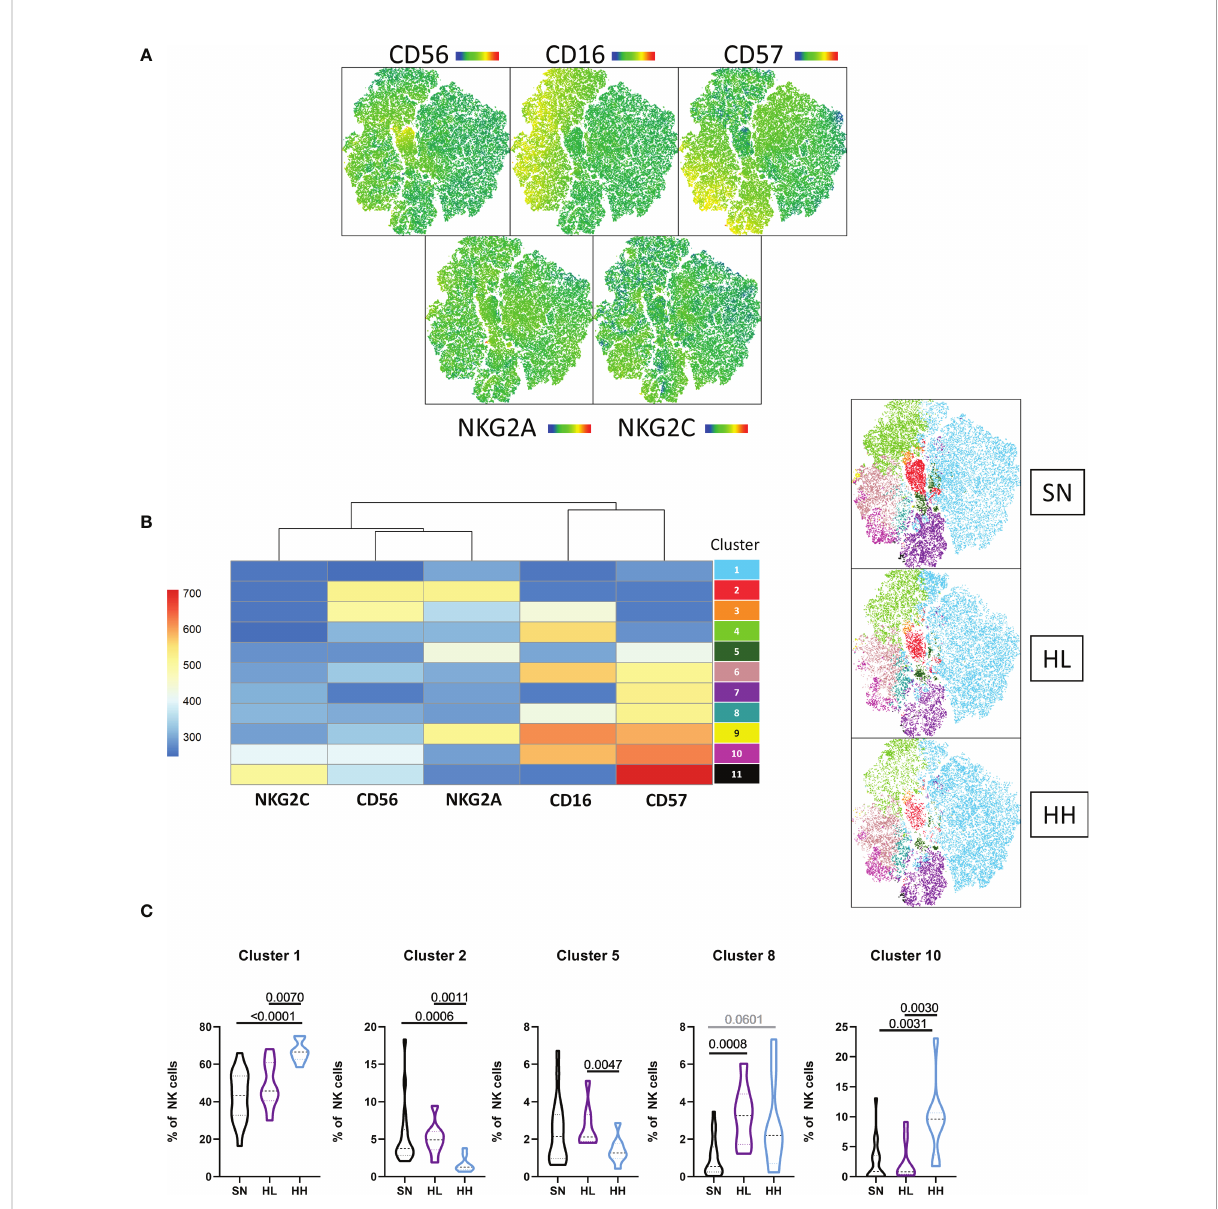
FIGURE 2 Unsupervised analysis of the NK cell repertoire. (A) tSNE dimensional reduction was performed in the CD3 negative fraction of magnetically- sorted NK-cells, based on the expression of CD56, CD16, CD57, NKG2A and NKG2C in a cohort of HIV seronegative individuals (SN, n=18), HIV- low (HL, n=8) and HIV-high (HH, n=8). (B) A total of 11 clusters was identi fi ed by X-shift and FLOWSOM was applied to determine their speci fi c markers. (C) Comparison of clusters differentially represented in the different groups. Comparisons between groups were evaluated by Mann- Whitney test for non-parametric data. Results were considered statistically signi fi cant when p-value <0.05 while trends are shown in